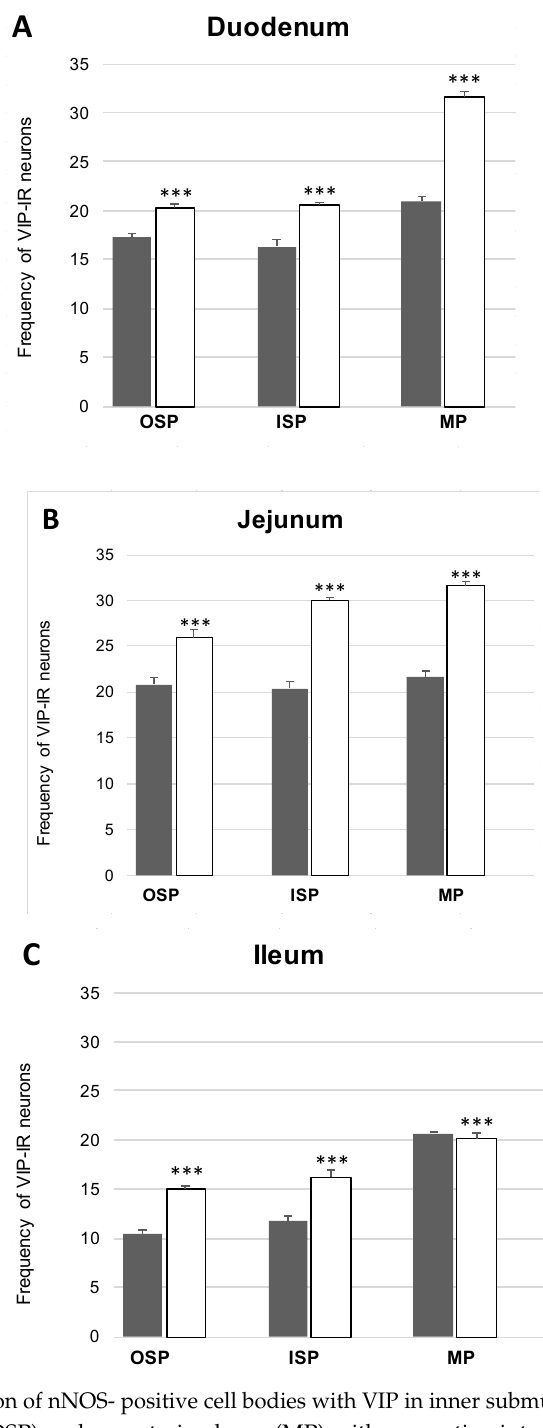
Figure 3. Colocalization of nNOS- positive cell bodies with VIP in inner submucous plexus (ISP), outer submucous plexus (OSP) and myenteric plexus (MP) with vasoactive intestinal polypeptide (VIP) within the duodenum, jejunum and ileum in the control and experimental groups. Mean ( ± SEM) percentage of neurons immunoreactive to n NOS and VIP in the MP- myenteric plexus, OSP- intestinal outer submucous plexus, ISP- intestinal inner submucous plexus in the duodenum ( A ), jejunum ( B ) and ileum ( C ). Control (grey bars), experimental (white bars), *** p < 0.001—indicate differences between control and experimental group.